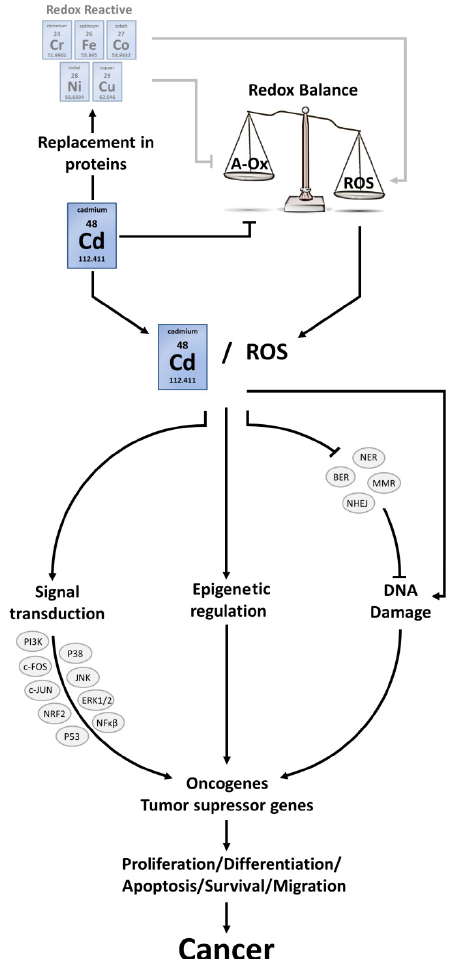
Figure 2. Schematic overview of Cd-induced carcinogenesis. Reactive oxygen species (ROS); nucleotide excision repair (NER); base excision repair (BER); mismatch repair (MMR); non-homologous end-joining (NHEJ); phosphatidylinositide 3-kinases (PI3K); mitogen activated protein kinase p38 (P38); c-Jun N-terminal kinase (JNK); nuclear factor (erythroid-derived 2)-like 2 (NRF2); extracellular-signal-regulated kinases (ERK); tumour protein 53 (P53); nuclear factor kappa-light-chain-enhancer of activated B cells (NF κβ